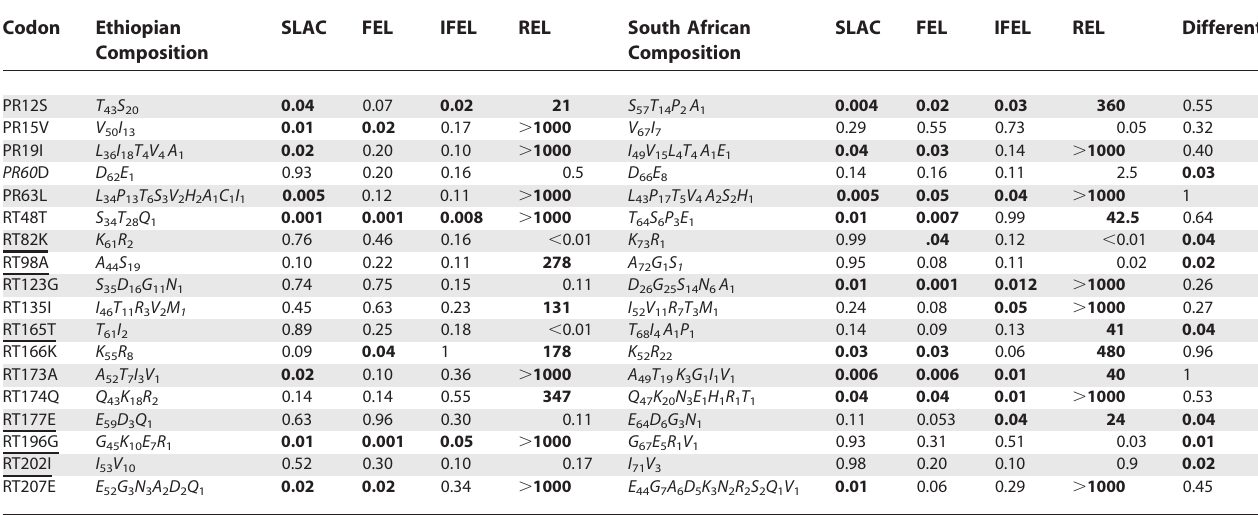
SLAC FEL IFEL REL South African